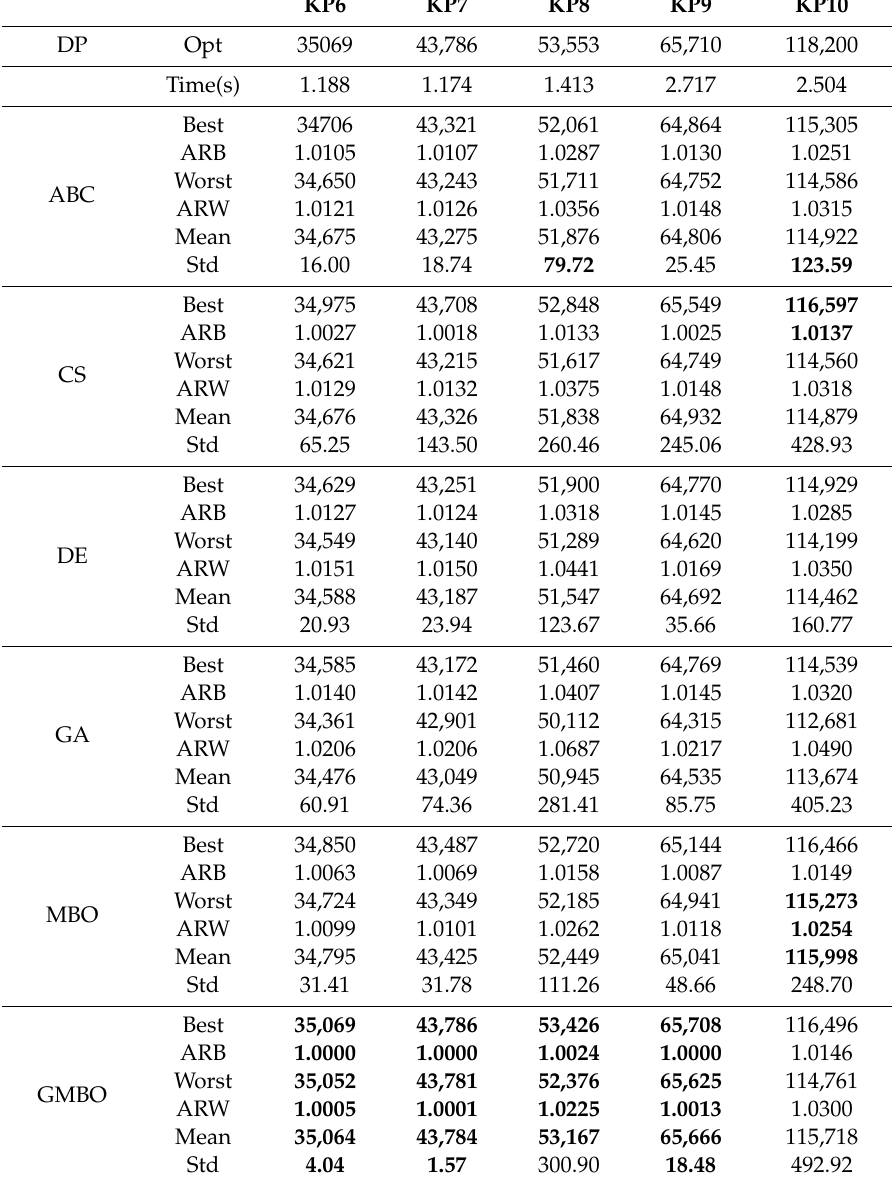
Table 9. Performance comparison of large-scale five weakly correlated 0-1KP